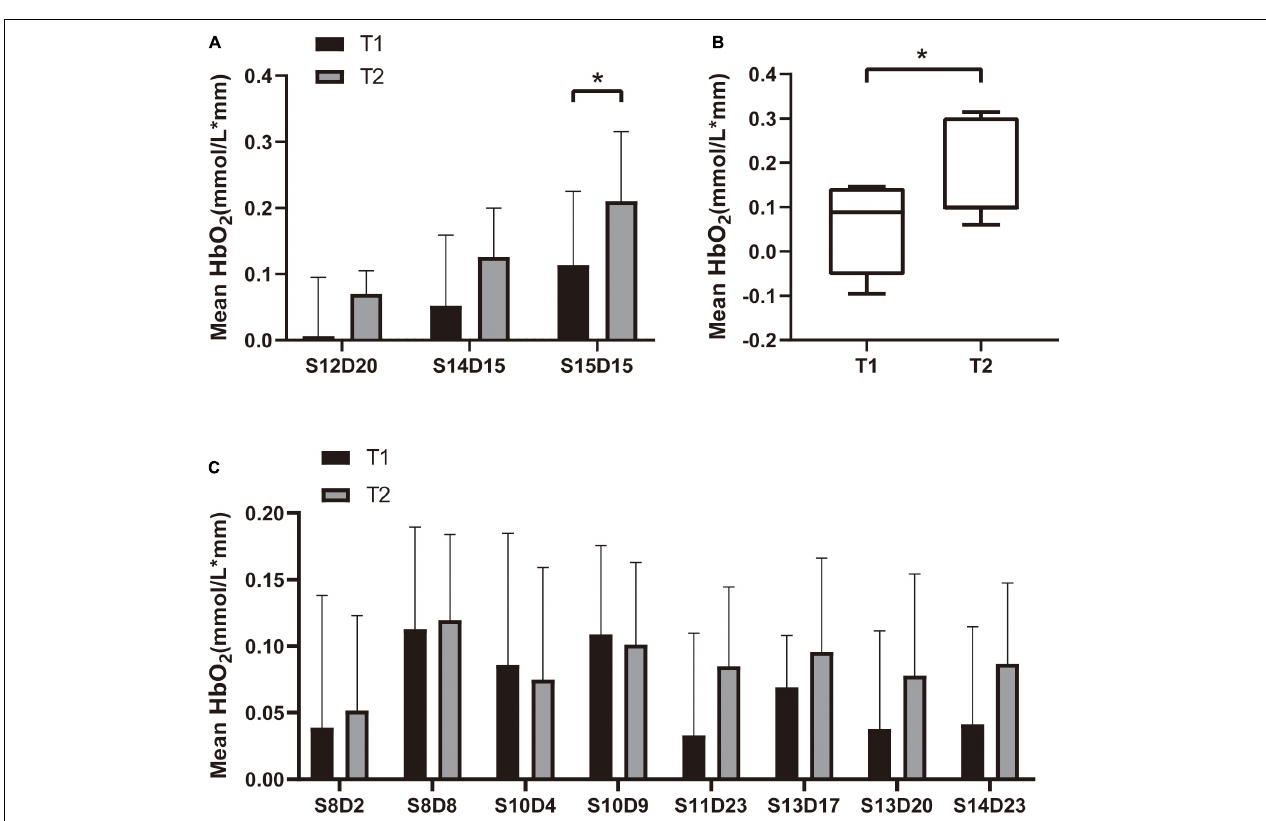
FIGURE 4 | Mean HbO 2 for each channel in the (A) SMA (S12D20, S14D15 and S15D15), (B) SMA (S12D14), and (C) DLPFC. We plot the mean with SD in panels (A,C) , and median with min to max in panel (B) . * P < 0.05.